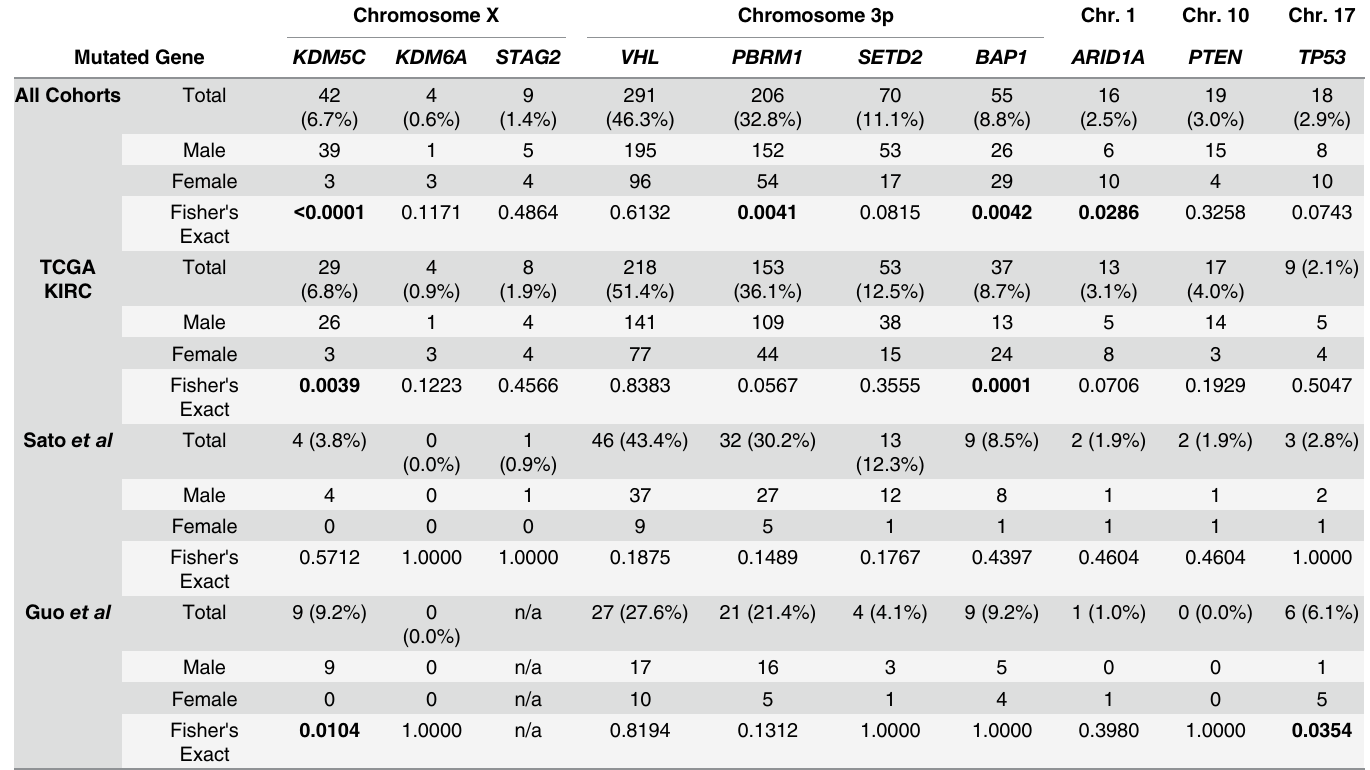
Table 1. Analysis of Mutation Frequency in 10 Genes Commonly Mutated in